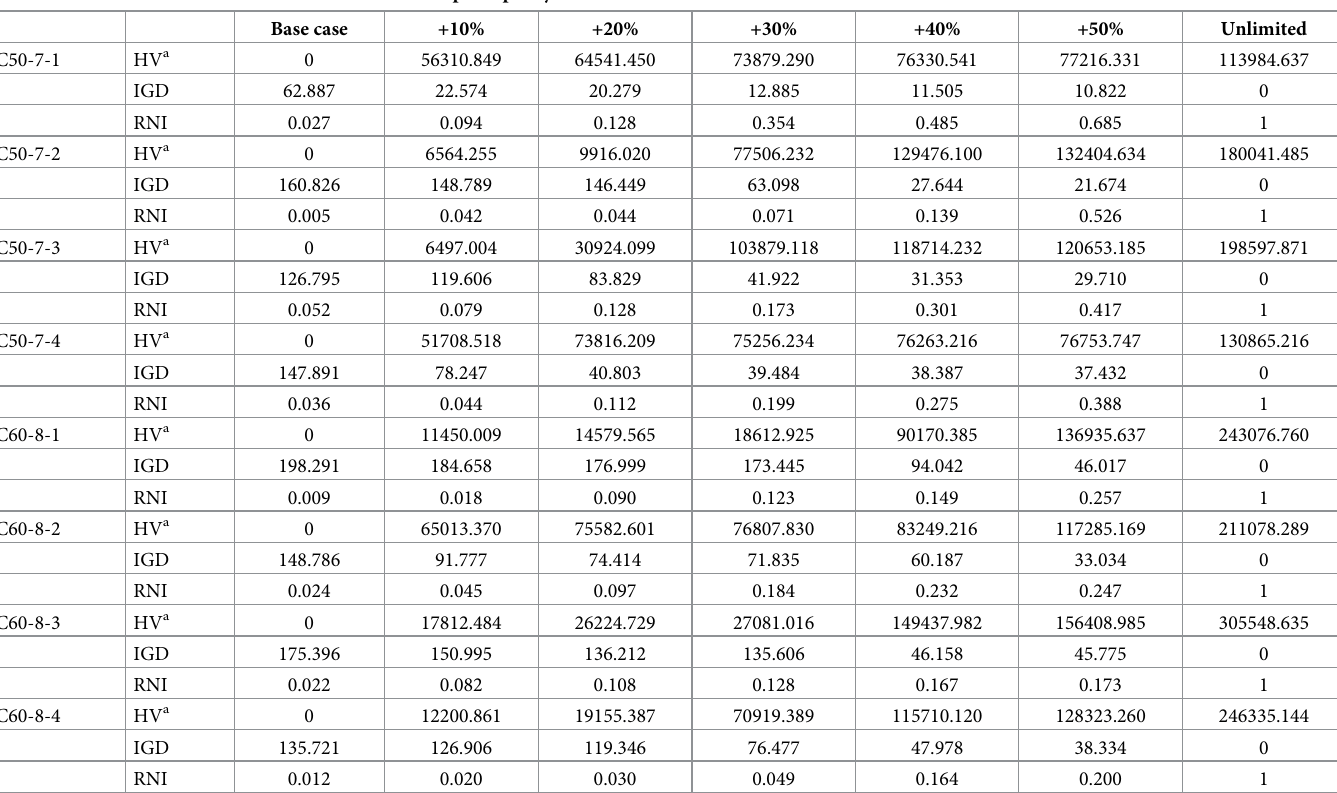
Table 6. Performance indicators of seven variants of depot capacity.